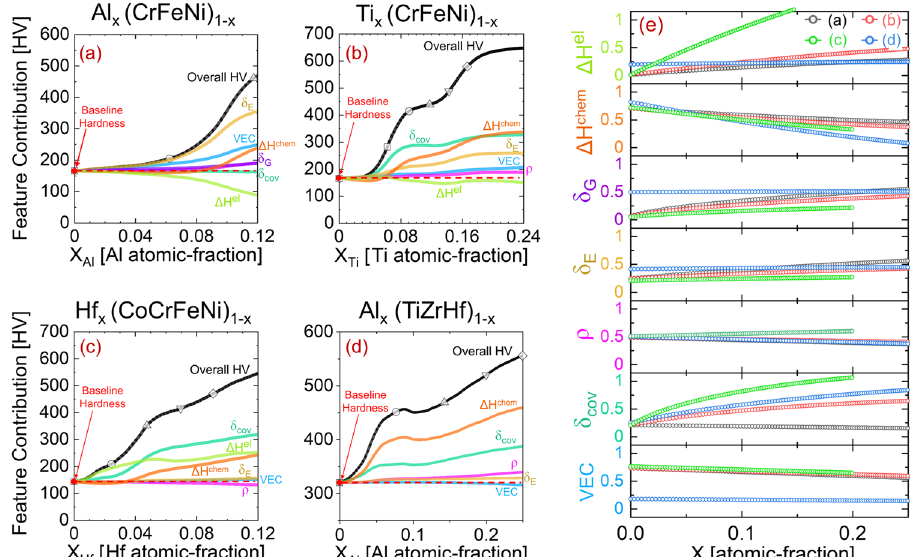
Fig. 6 Visualizing the decision-making process of ML model. Contribution of different features toward ML hardness prediction in: a Al x (CrFeNi) 1- x , b Ti x (CrFeNi) 1- x , c Hf x (CoCrFeNi) 1- x , and d Al x (TiZrHf) 1- x alloy systems. At any composition ( x ), the cumulative hardness contribution of each feature is equal to the vertical distance between that feature contribution plot and the baseline hardness value (calculated at x = 0). At any x , the summation of baseline hardness and all feature contributions will result in overall hardness. e Feature variations with respect to composition for alloy systems shown in a – d . Normalized feature values have been plotted here. Feature notations: VEC-Valence electron concentration, δ cov -asymmetry in covalent radius, ρ -average density, δ E -asymmetry in Young ’ s modulus, δ G -asymmetry in shear modulus, Δ H chem -chemical enthalpy of mixing, Δ H el -elastic enthalpy of mixing. Features that had negligible contribution to hardness prediction over these composition ranges have not been included in the